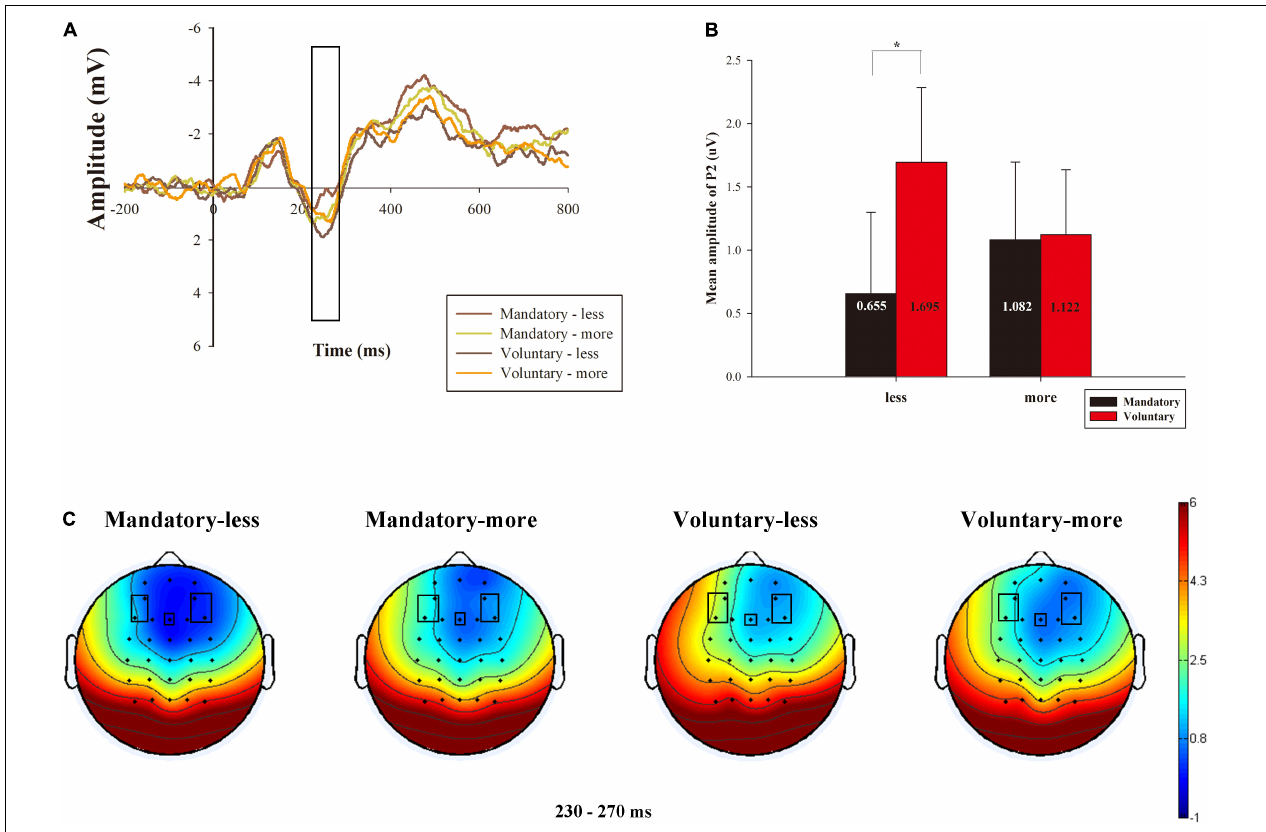
FIGURE 4 | Grand-averaged ERP waveforms of P2 about the average activity of all the electrodes, the mean amplitude of P2 and related brain topography. (A) P2 amplitude comparison of the four conditions of 2 donation contexts (mandatory vs. voluntary) × 2 amounts (less vs. more) about the average activity of all the electrodes. (B) The mean amplitude of P2 for the four conditions. (C) The brain topography of the four conditions and contrast at the P2 time window of 230 ∼ 270 ms. * p <